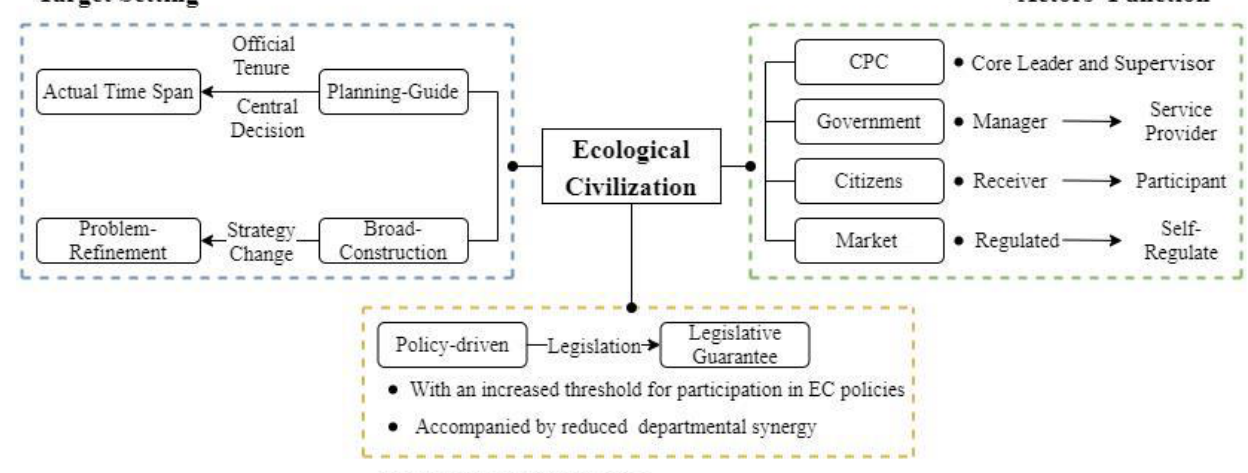
Figure 6. Core elements of EC and their